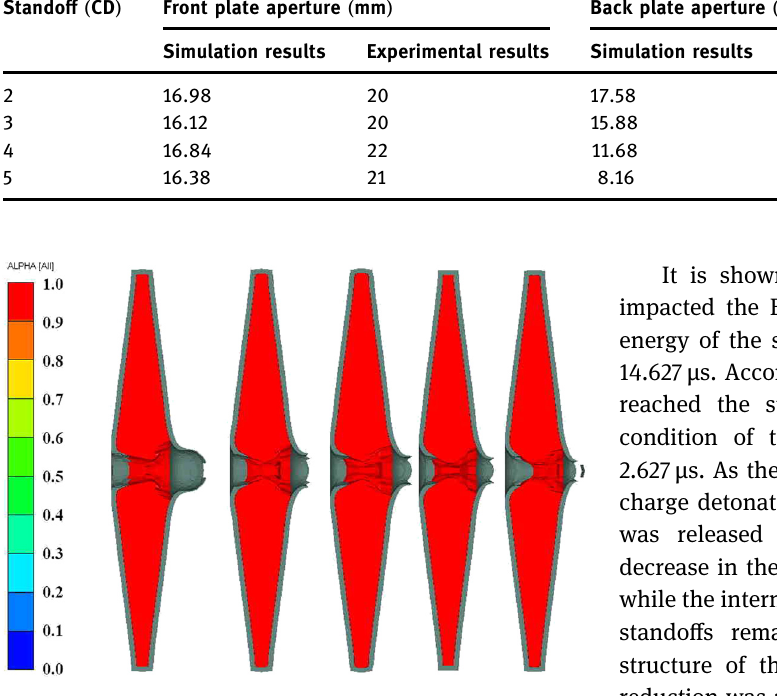
Figure 11: Reactivity of the ERA impacted by PA jets at di ff erent stando ff s.